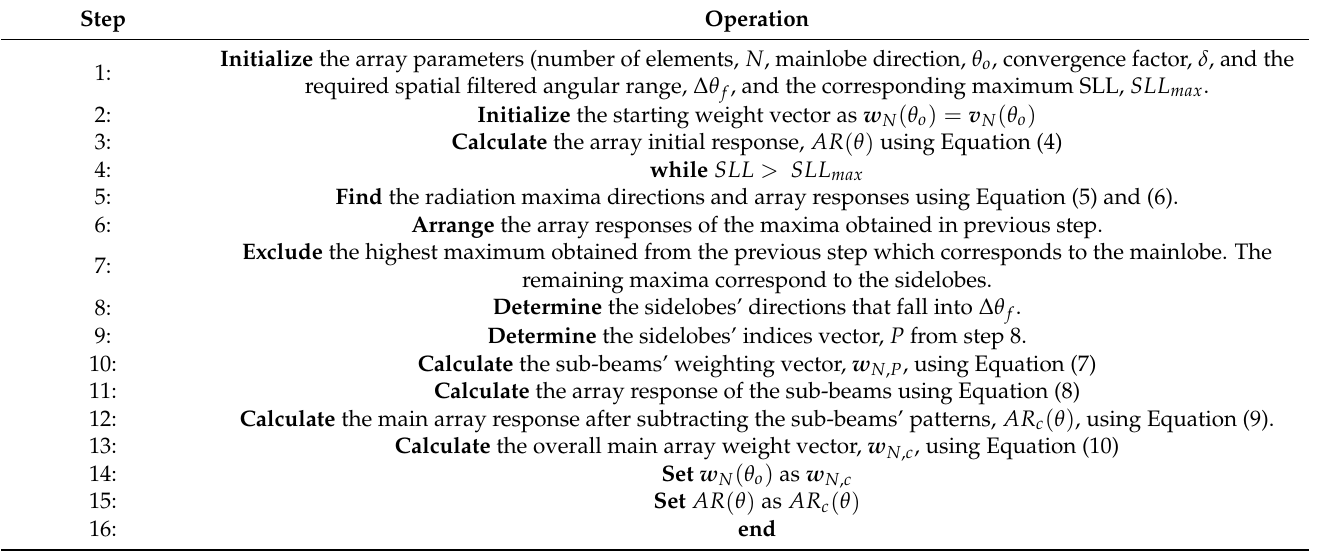
Table 2. Modified SSR algorithm for selective sidelobe reduction and spatial